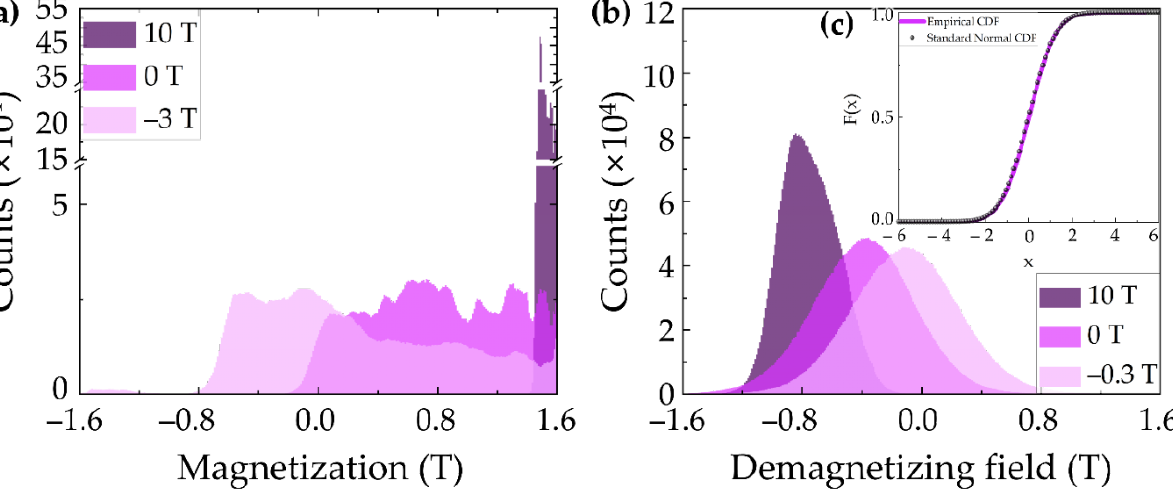
Figure 4. Histograms for cells with certain values for ( a ) magnetizations and ( b ) demagnetizing fields at 10 T (saturation), 0 T (remanent state), and − 3 T (during reversal). ( c ) Cumulative distribution function (CDF) for the computed demagnetizing field at the remanent state, and the standard normal CDF by the mean and the standard deviation of the demagnetizing field in each cell.